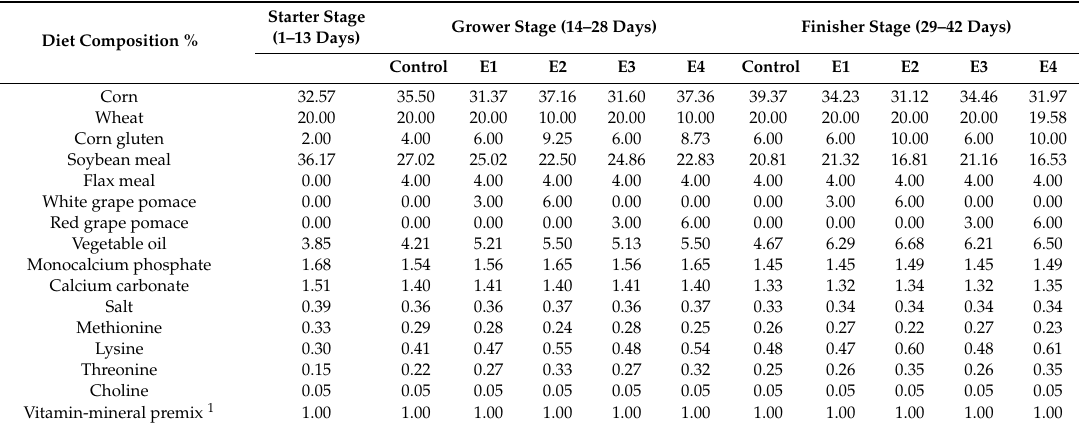
Table 1. Ingredients and chemical composition of broiler